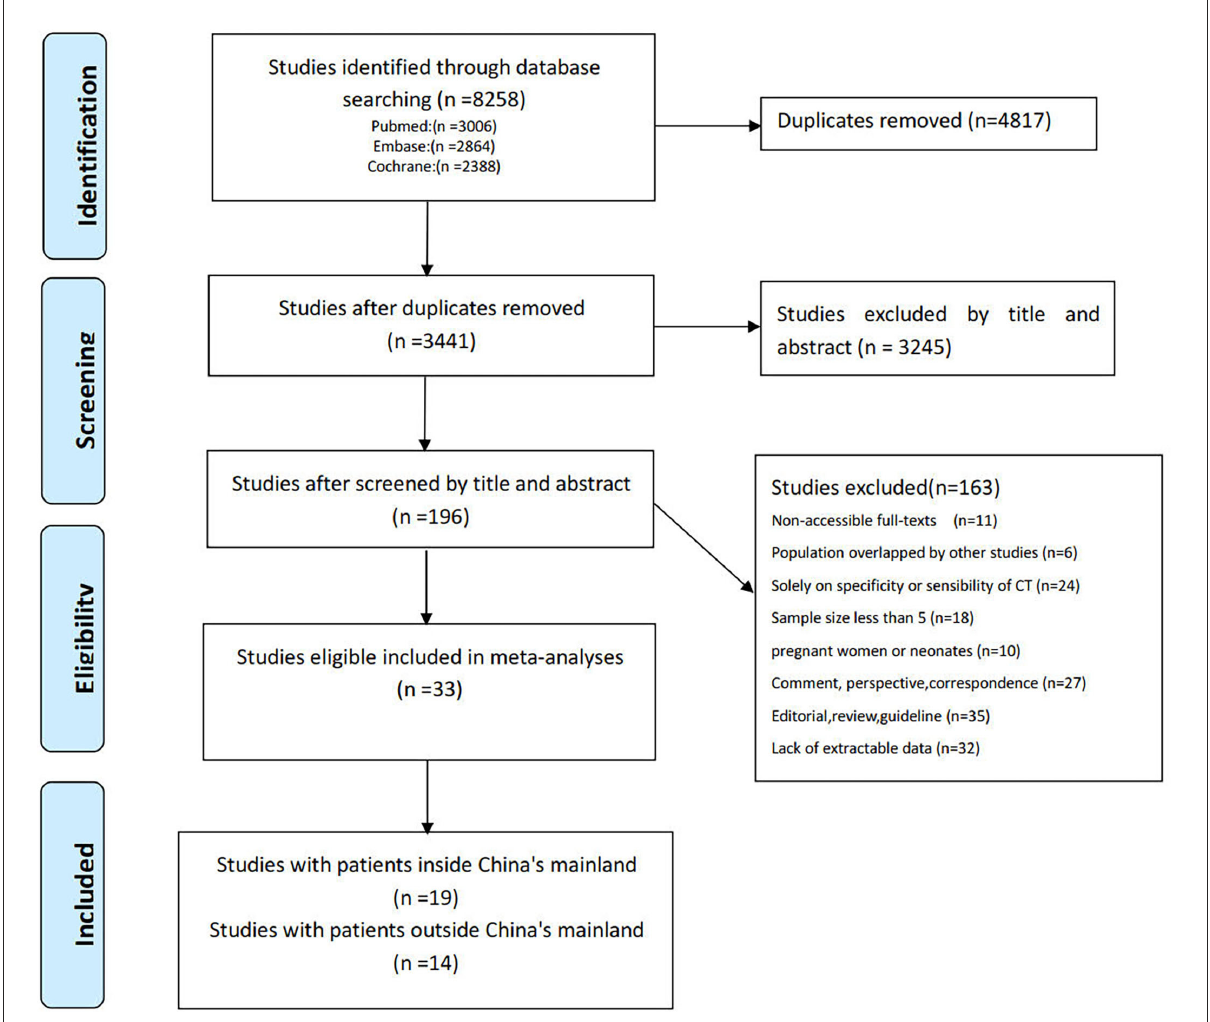
FIGURE1 Preferred Reporting Items for Systematic Reviews and Meta-Analyses guidelines (PRISMA) flow diagram of the study selection